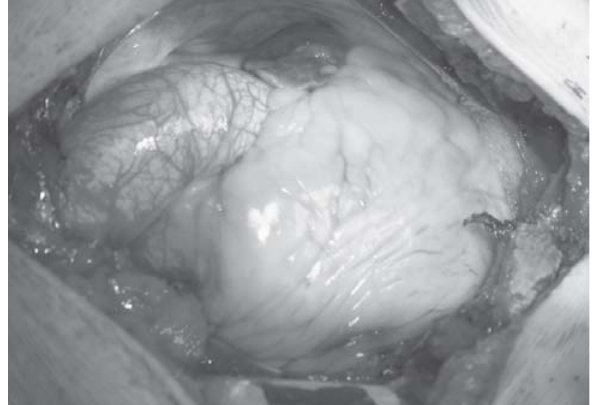
Fig. 4 - Anatomia cardíaca vista do lado direito da paciente: